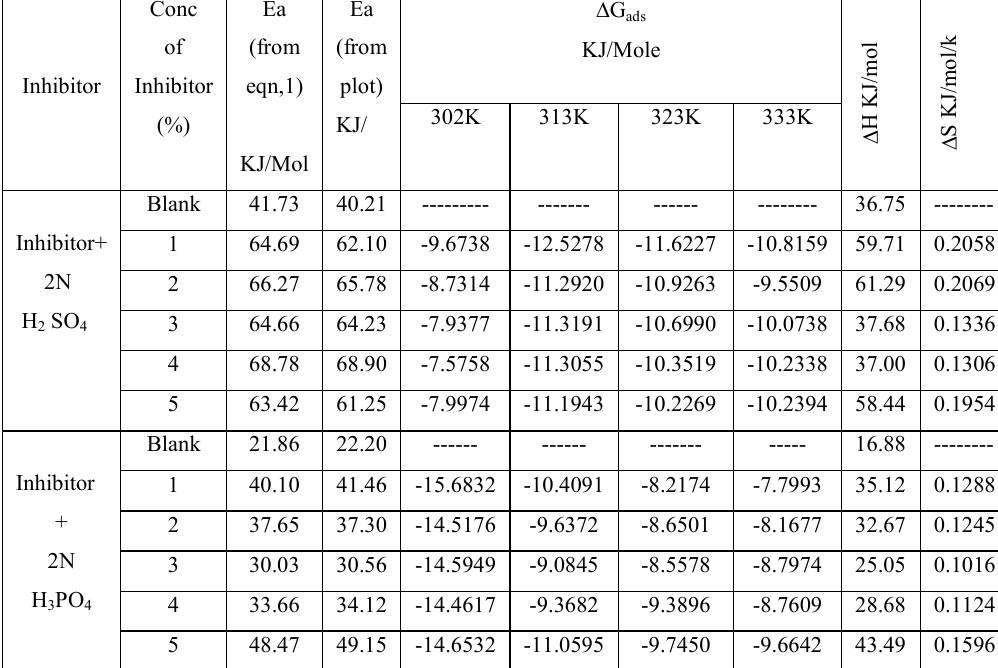
Table 2. Thermodynamic parameters for mild steel in 2N sulphuric acid and 2N phosphoric acid with